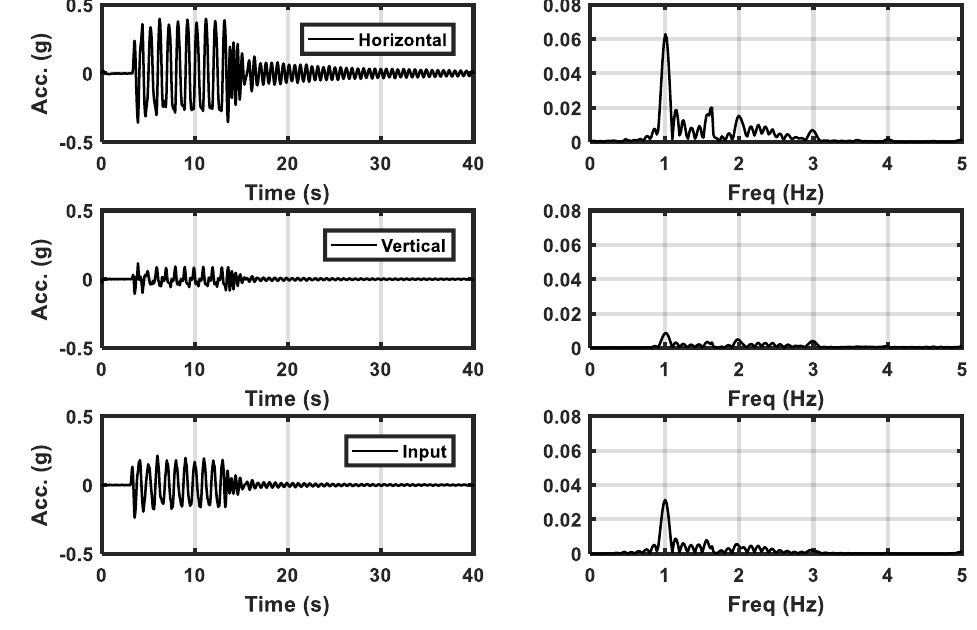
Figure 14. Structural response to a sinusoidal motion.